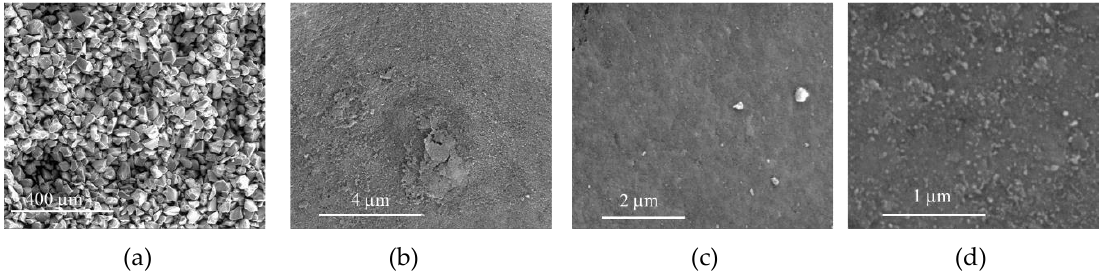
Figure 17. SEM micrographs of CAT-4-MR-TBHP after five cycles in oxidation reactions using TBHP